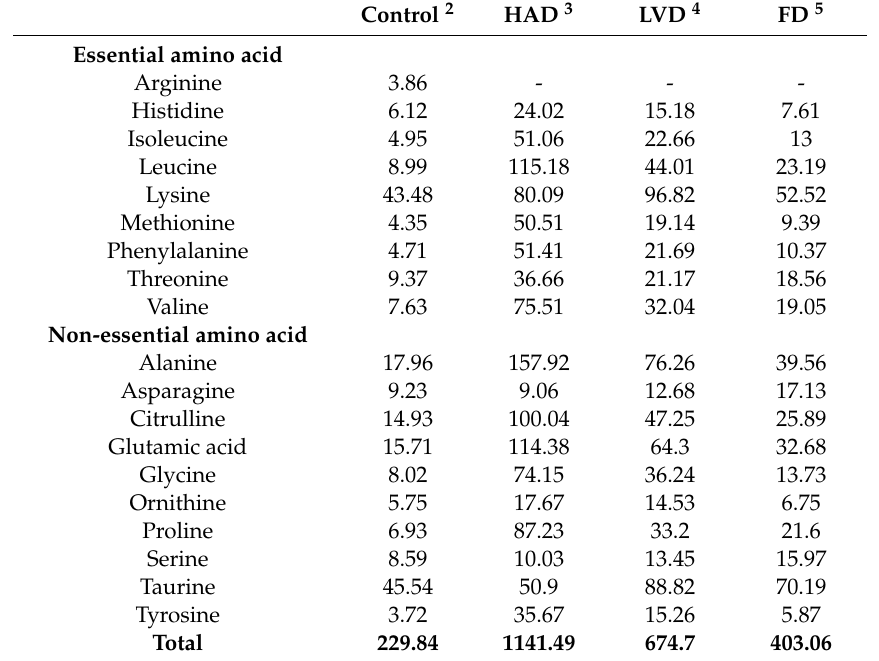
Table 2. Analysis of 18 free amino acids in the yellow croakers by various drying methods (mg/100 g) 1.